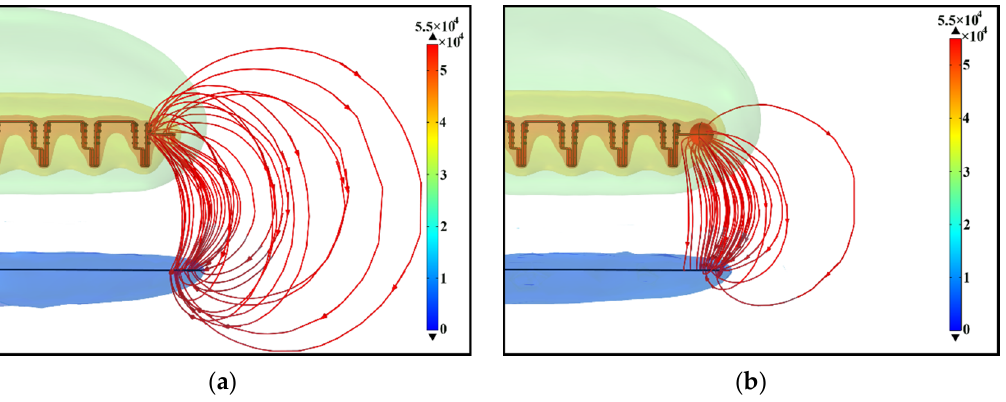
Figure 12. Effect of the metal sphere on the electric field streamlines at the starting point of the series-connected submodules: ( a ) initial condition; ( b ) after adding metal sphere.